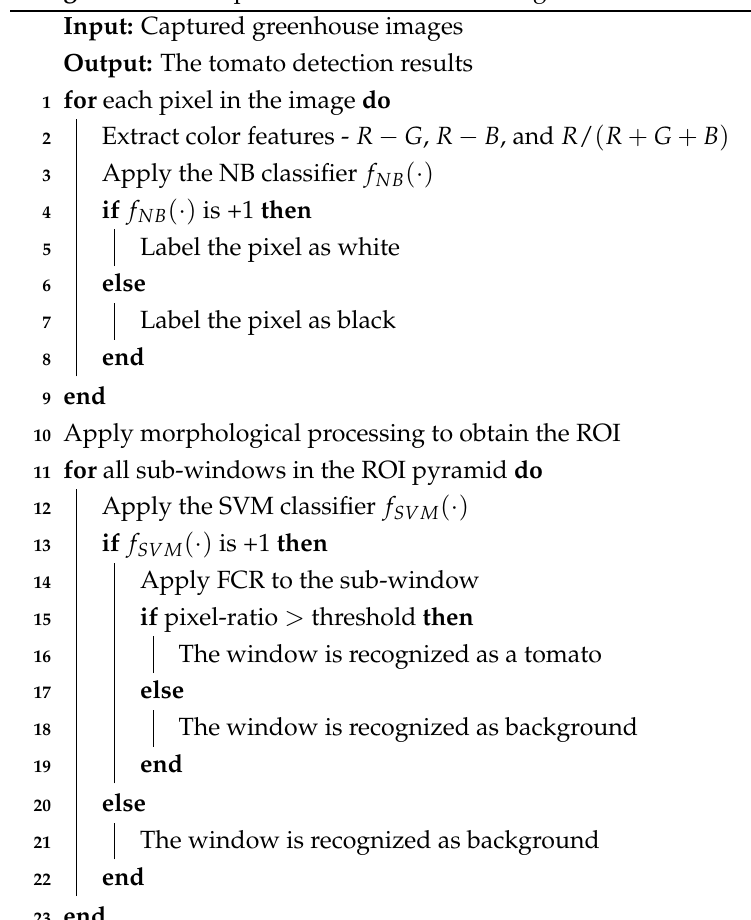
Algorithm 1: The pseudo code of the scanning